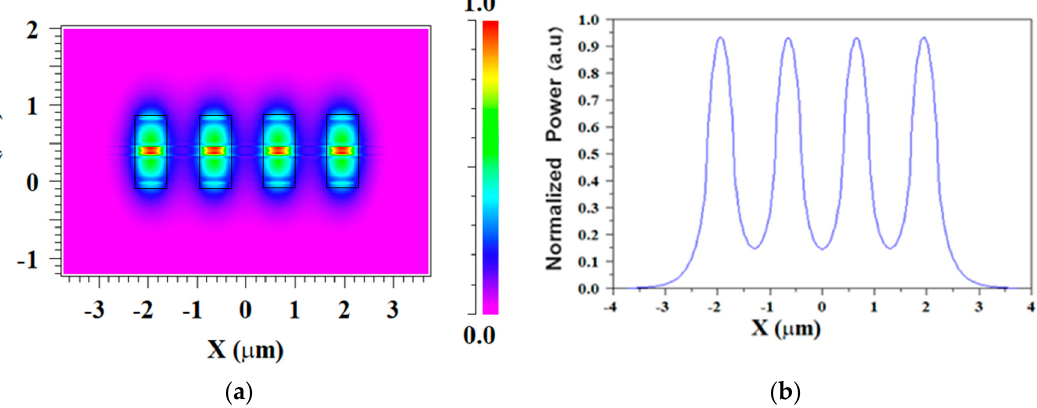
Figure 4. TM fundamental mode solution for four slot waveguide structures: ( a ) E y mode field pattern; ( b ) horizontal cut at y = 400 nm.